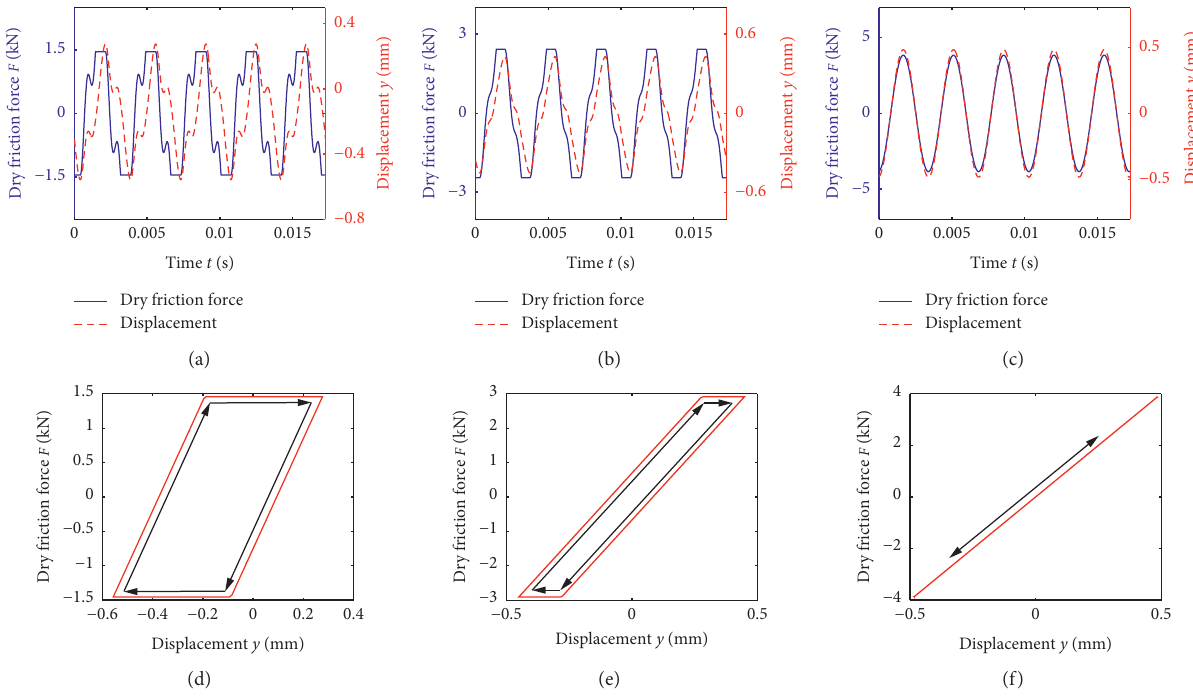
Figure 23: Dry friction force for different friction coefficients: (a–c) represent the dry friction force curve and the response curve; (d–f) describe the hysteresis